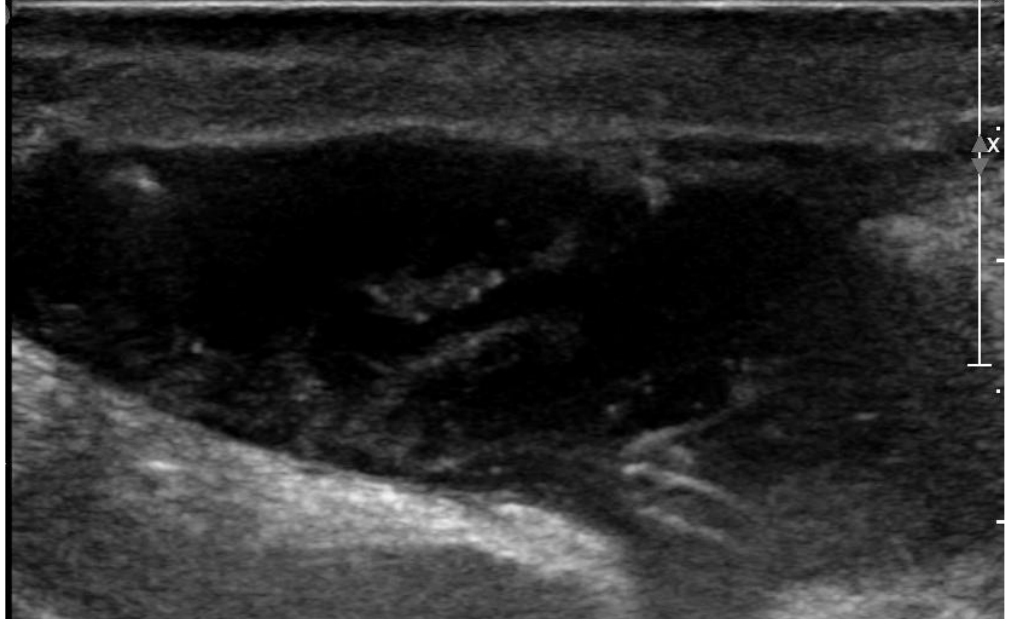
Figure 4. Two-dimensional grayscale ultrasonographic image of the swelling at the level of the surgical wound of the jugular venous incision shows a pocket of fluid accumulation.